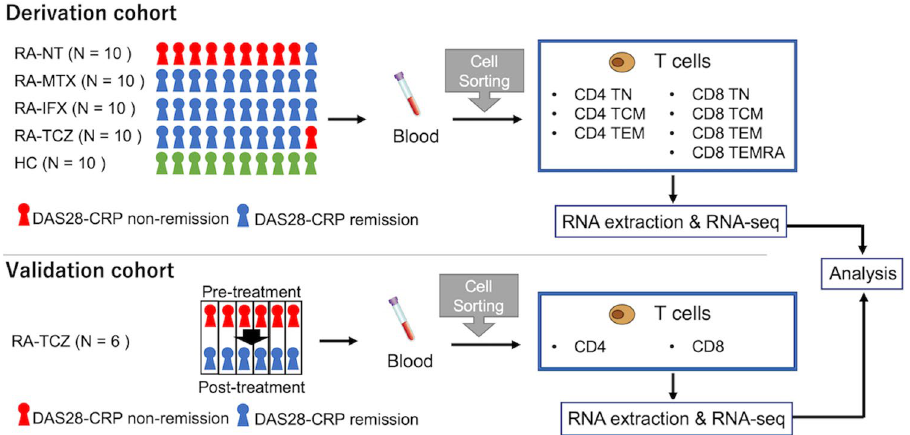
Figure 1. Workflow of the current study. We used 2 cohorts: a derivation cohort including cross-sectional subjects and a validation cohort including longitudinal subjects treated by TCZ. In the derivation cohort, we measured gene expression according to cell subpopulations and summarized all CD4 + T cells and CD8 + T cells in the expression analysis. HC, healthy control; IFX, infliximab; MTX, methotrexate; RA, rheumatoid arthritis; NT, non-treatment; TCM, central memory T cell; TCZ, tocilizumab; TEM, effector memory T cell; TEMRA, CD45RA-positive effector memory T cell; TN, naïve T